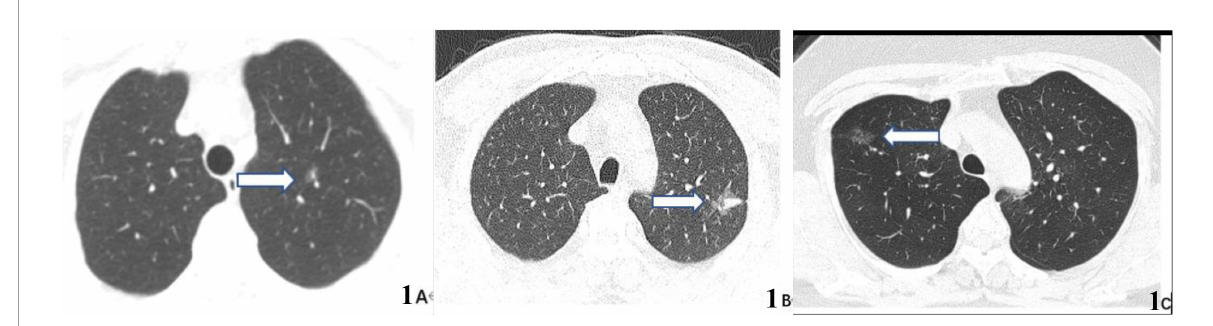
FIGURE6 CT images of three typical lung nodule types correctly distinguished by our proposed model while wrongly determined by radiologist. (A) 59-year-old woman, CT scan of the chest showing a ground glass nodule in the upper lobe of the left lung with post-operative pathological result of adenocarcinoma in situ (AIS) (arrow). (B) 63-year-old man, CT scan of the chest showing a mixed ground glass nodule in the upper lobe of the left lung with post-operative pathological result of invasive adenocarcinoma (IA) (arrow). (C) 36-year-old man, CT scan of the chest showing a pure ground-glass nodule in the upper lobe of the right lung, which suggests an inflammatory lesion (arrows) owing to its disappearance on reexamination 3 months